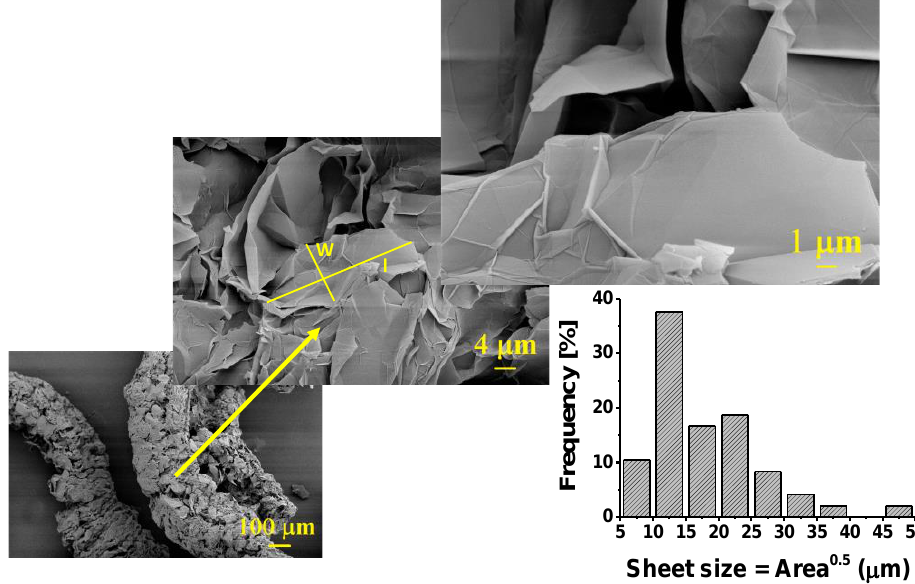
Figure 1. SEM image of the graphene additives and their size distribution.